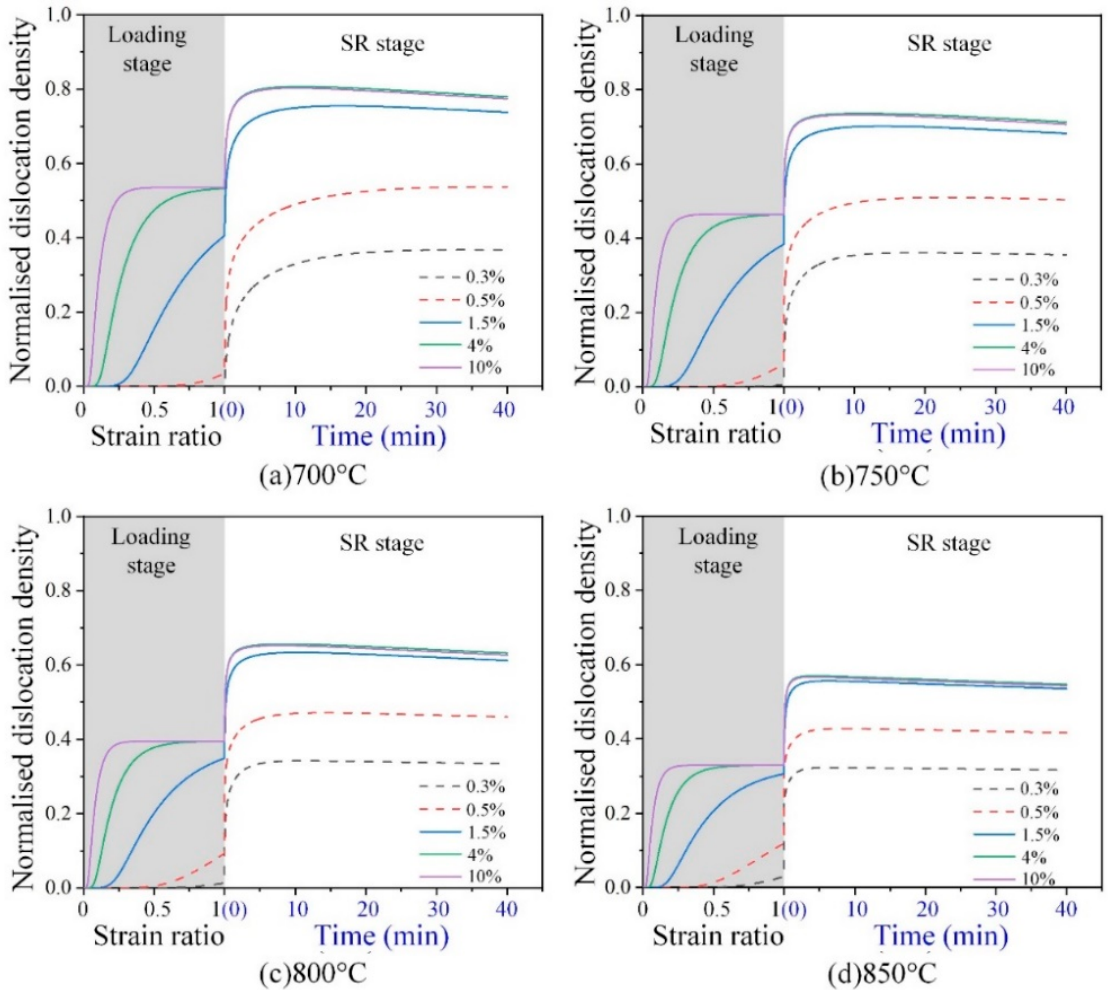
Figure 13. Prediction of normalized dislocation density with different temperatures and pre-strain levels, ( a ) 700 °C, ( b ) 750 °C, ( c ) 800 °C and ( d ) 850 °C.